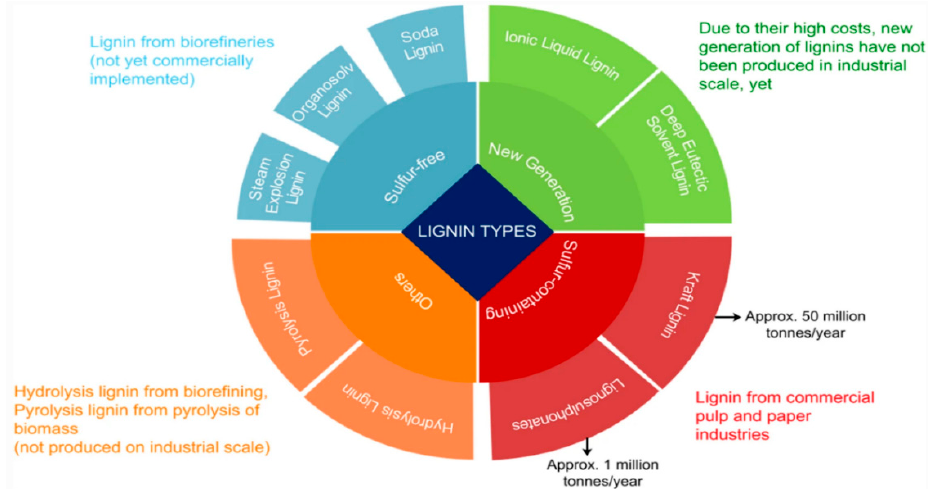
Figure 1. The most common lignin derivatives known in the literature, their sources, production, and classi fi cation [65].